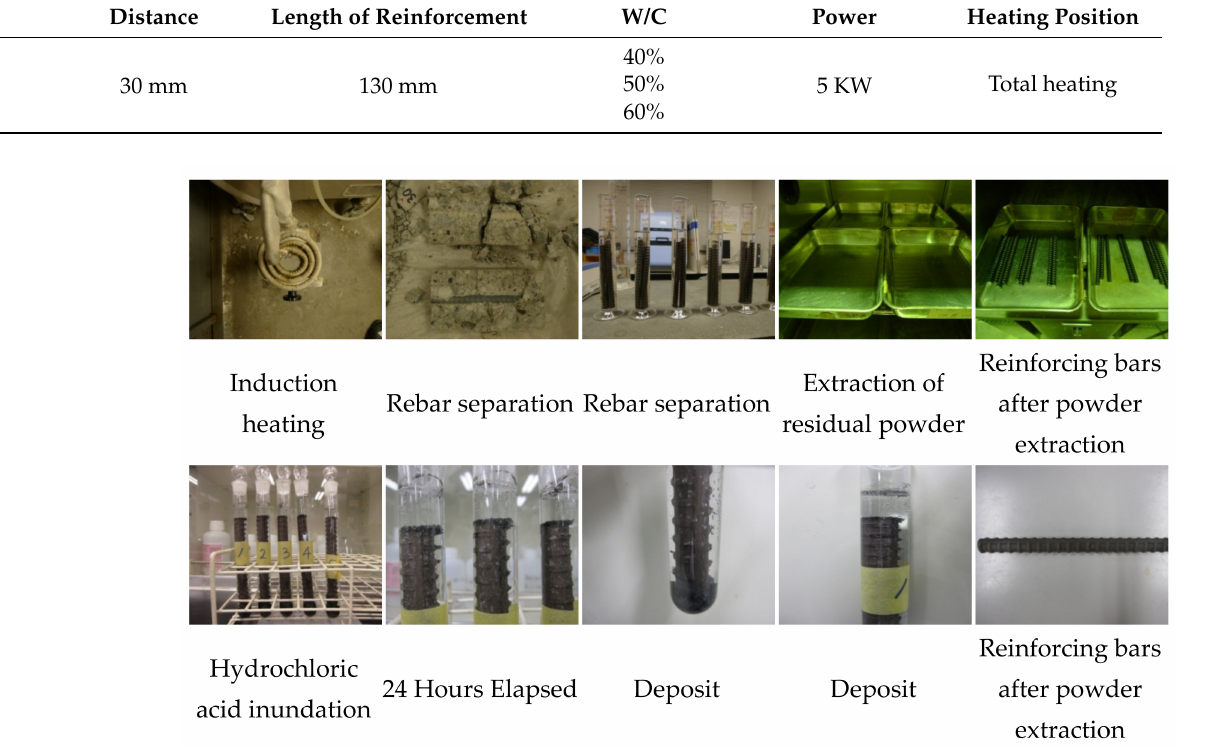
Figure 19. Workflow of the rebar recovery